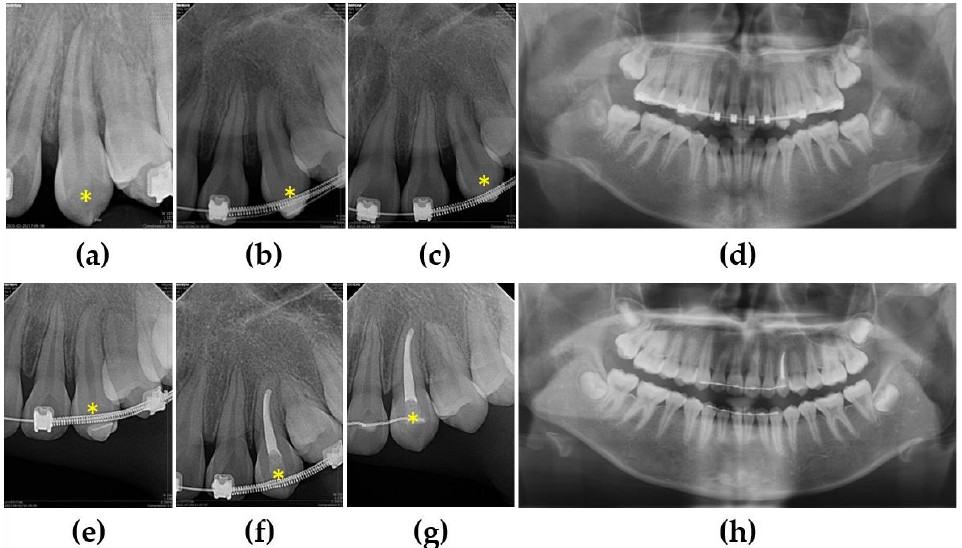
Figure 8. Radiographic examinations. The transplanted tooth is indicated with a yellow asterisk (*). Radiographs obtained on the day of autotransplantation ( a ), 1 week ( b ), 1 month ( c ), 3 months ( d , e ), 5 months ( f ), 14 months ( g ), and 2 years ( h ) postoperatively.